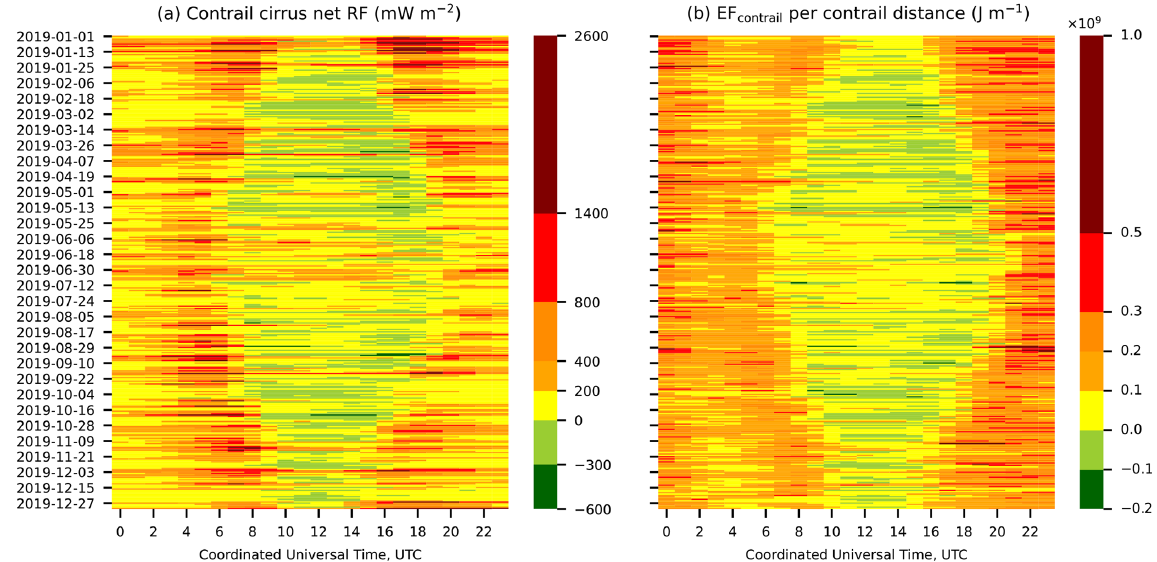
Figure 3. The regional (a) contrail cirrus net RF and (b) EF contrail per contrail distance in the North Atlantic flight corridor for each hour of 2019. The hourly mean SDR that is used to identify the sunrise and sunset times in this region is shown in Fig. S16 (Sect.